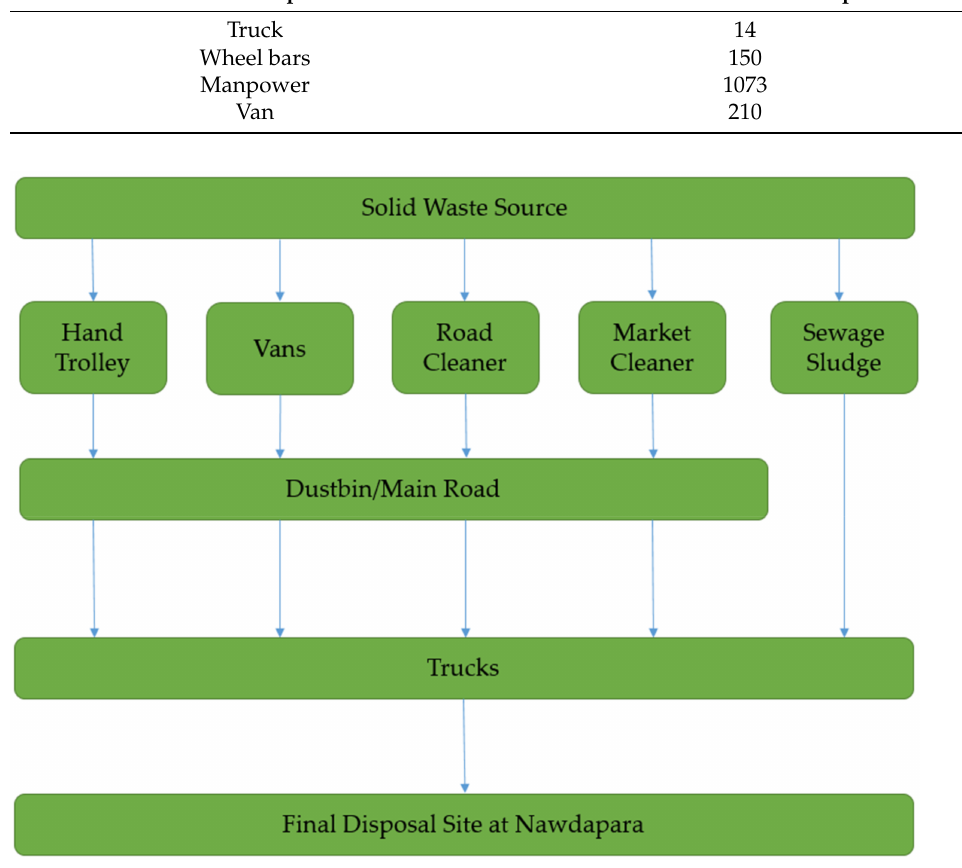
Figure 4. MSW management scenario of Rajshahi City Corporation